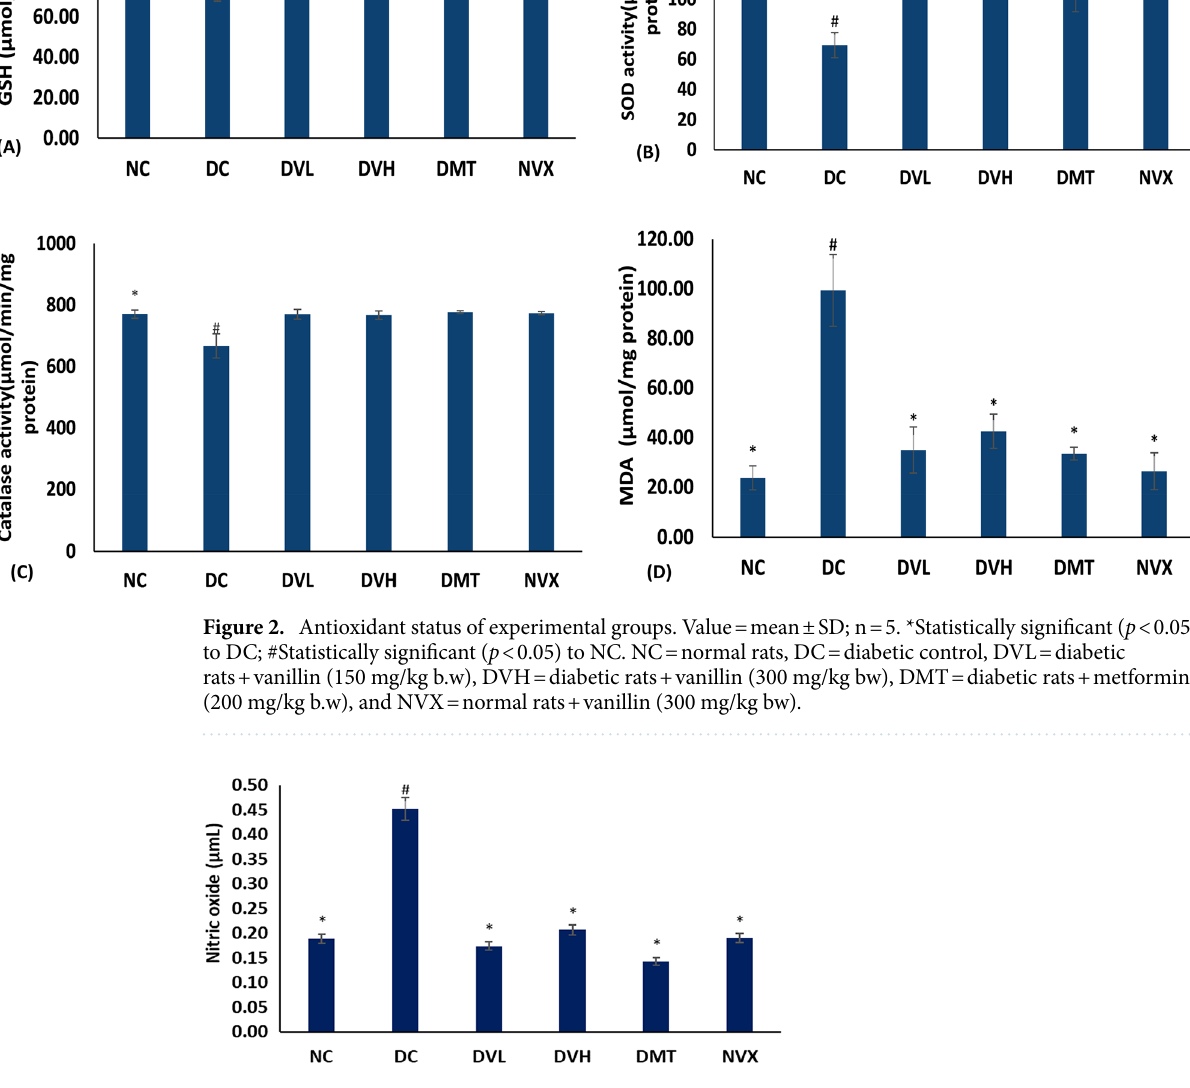
Figure 3. Nitric oxide levels of experimental groups. Value = mean ± SD; n = 5. *Statistically significant ( p < 0.05) to DC; #Statistically significant ( p < 0.05) to NC. NC = normal rats, DC = diabetic control, DVL = diabetic rats + vanillin (150 mg/kg b.w), DVH = diabetic rats + vanillin (300 mg/kg bw), DMT = diabetic rats + metformin (200 mg/kg b.w), and NVX = normal rats + vanillin (300 mg/kg